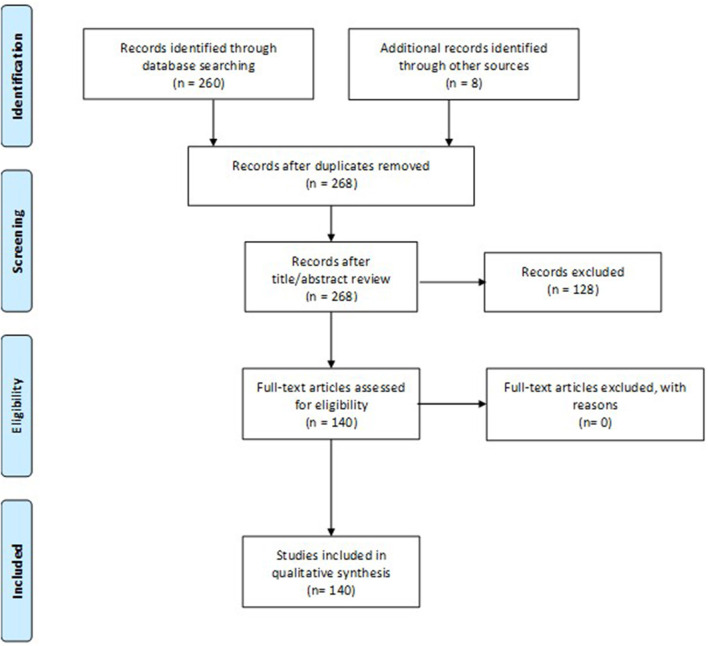
PRISMA Flow diagram.